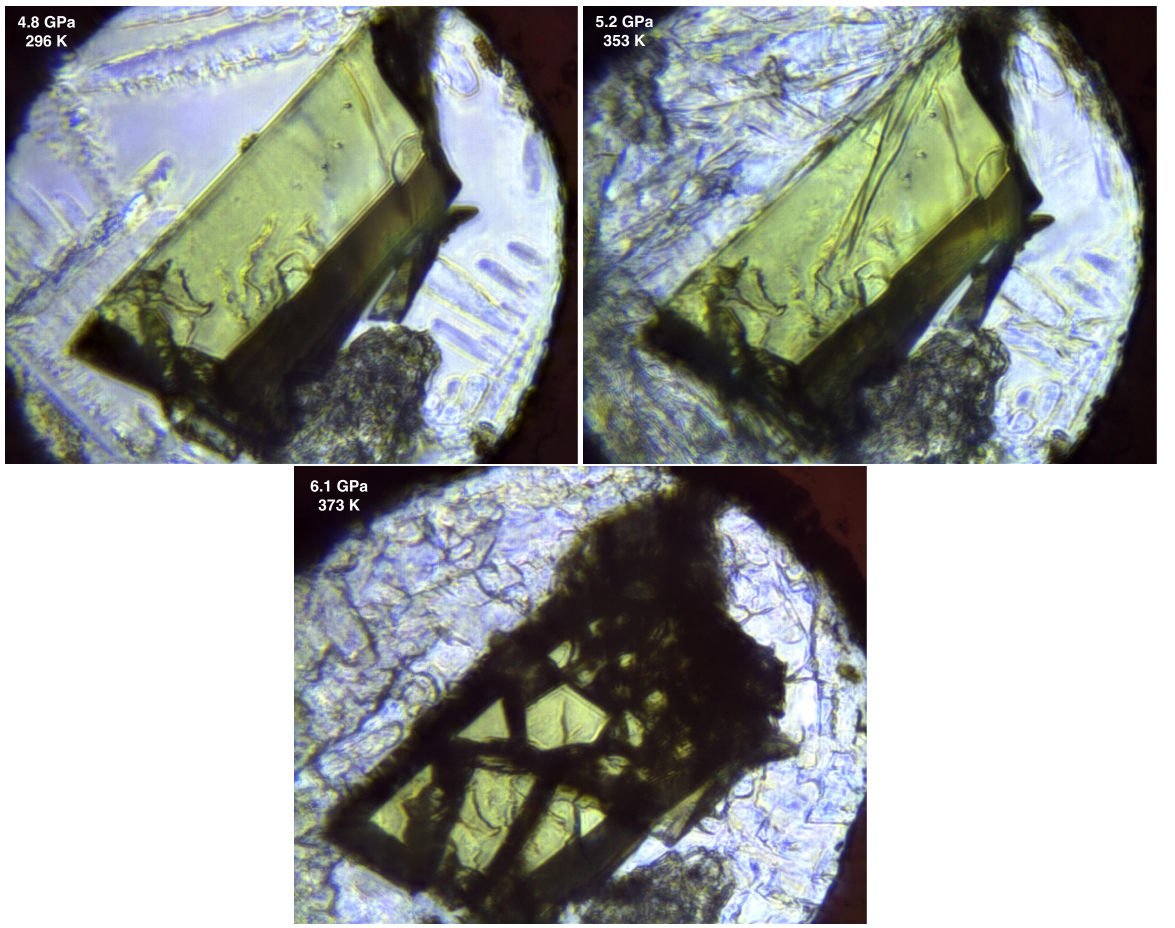
Figure A5. Sample and high-pressure sensor in the high-pressure diamond anvil cell (DAC) at different pressure–temperature conditions; 4:1 methanol–ethanol alcohol mixture as a pressure transmitting